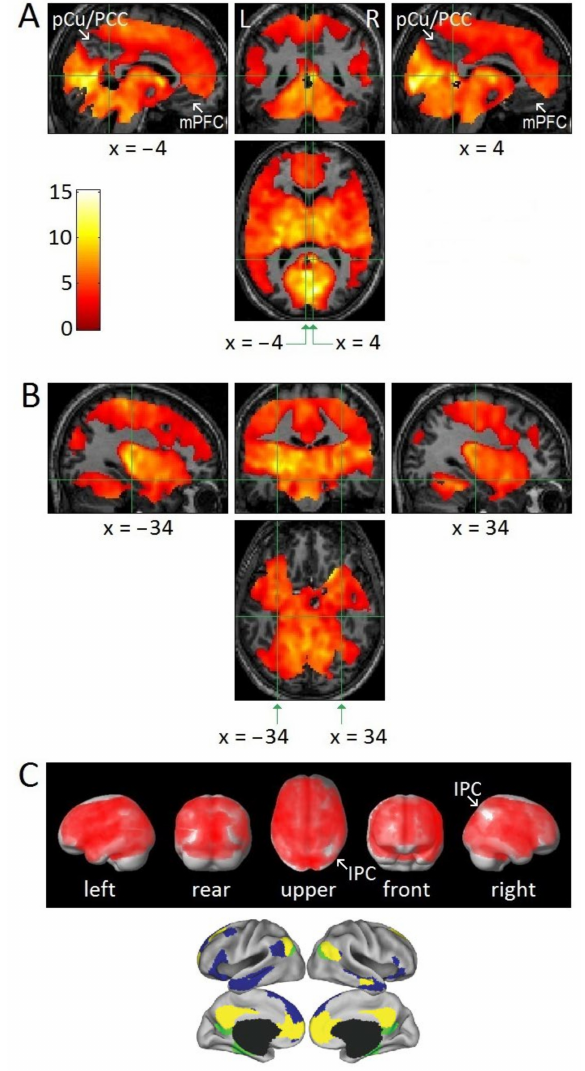
Figure 1. Areas of undetectable or attenuated REM-locked activation. Uncorrected level of p < 0.05 was used to show areas of undetectable or attenuated activation, even at this low threshold: random- effects analysis (group analysis, n = 24, one-sample t -test). Green lines show the locations of the other orthogonal views. In ( A , B ), the upper left and right panels show sagittal views, the upper middle panel, a coronal view, and the lower panel, a axial view; the statistical parametric maps are superimposed on anatomical images and show an absence of significant REM-locked effects in several regions: ( A ) PCu/PCC and medial prefrontal cortex (mPFC) on the left and the right hemisphere. Crosshair at the RSC-Rt (4, − 46,12) and at the corresponding location in the contralateral hemisphere ( − 4, − 46,12). The pocket of no activation in RSC-Lt contrasts dramatically with the adjacent robust activation in RSC-Rt ( t = 10.5). Coronal and axial views prepared with SPM2 were previously published [13]. ( B ) Hippocampal formation on the left and the right hemispheres. Crosshairs at ( − 34, − 24, − 12) and (34, − 24, − 12). Note the absence of activation in much of the hippocampal formation. ( C ) REM-locked activation effects projected on to surface rendering of a template brain. Note further the absence of activation in IPC on the right hemisphere and in the homologous areas of the occipital lobes on both sides at this threshold: attenuated activation in IPC on the left hemisphere and bilaterally in inferior lateral temporal cortex and inferior frontal gyrus. Bottom figures were adapted from the large-scale meta-analyses of Andrews-Hanna et al. (2014) with the permission. DMN core (yellow), dorsal medial subsystem (blue), medial temporal subsystem